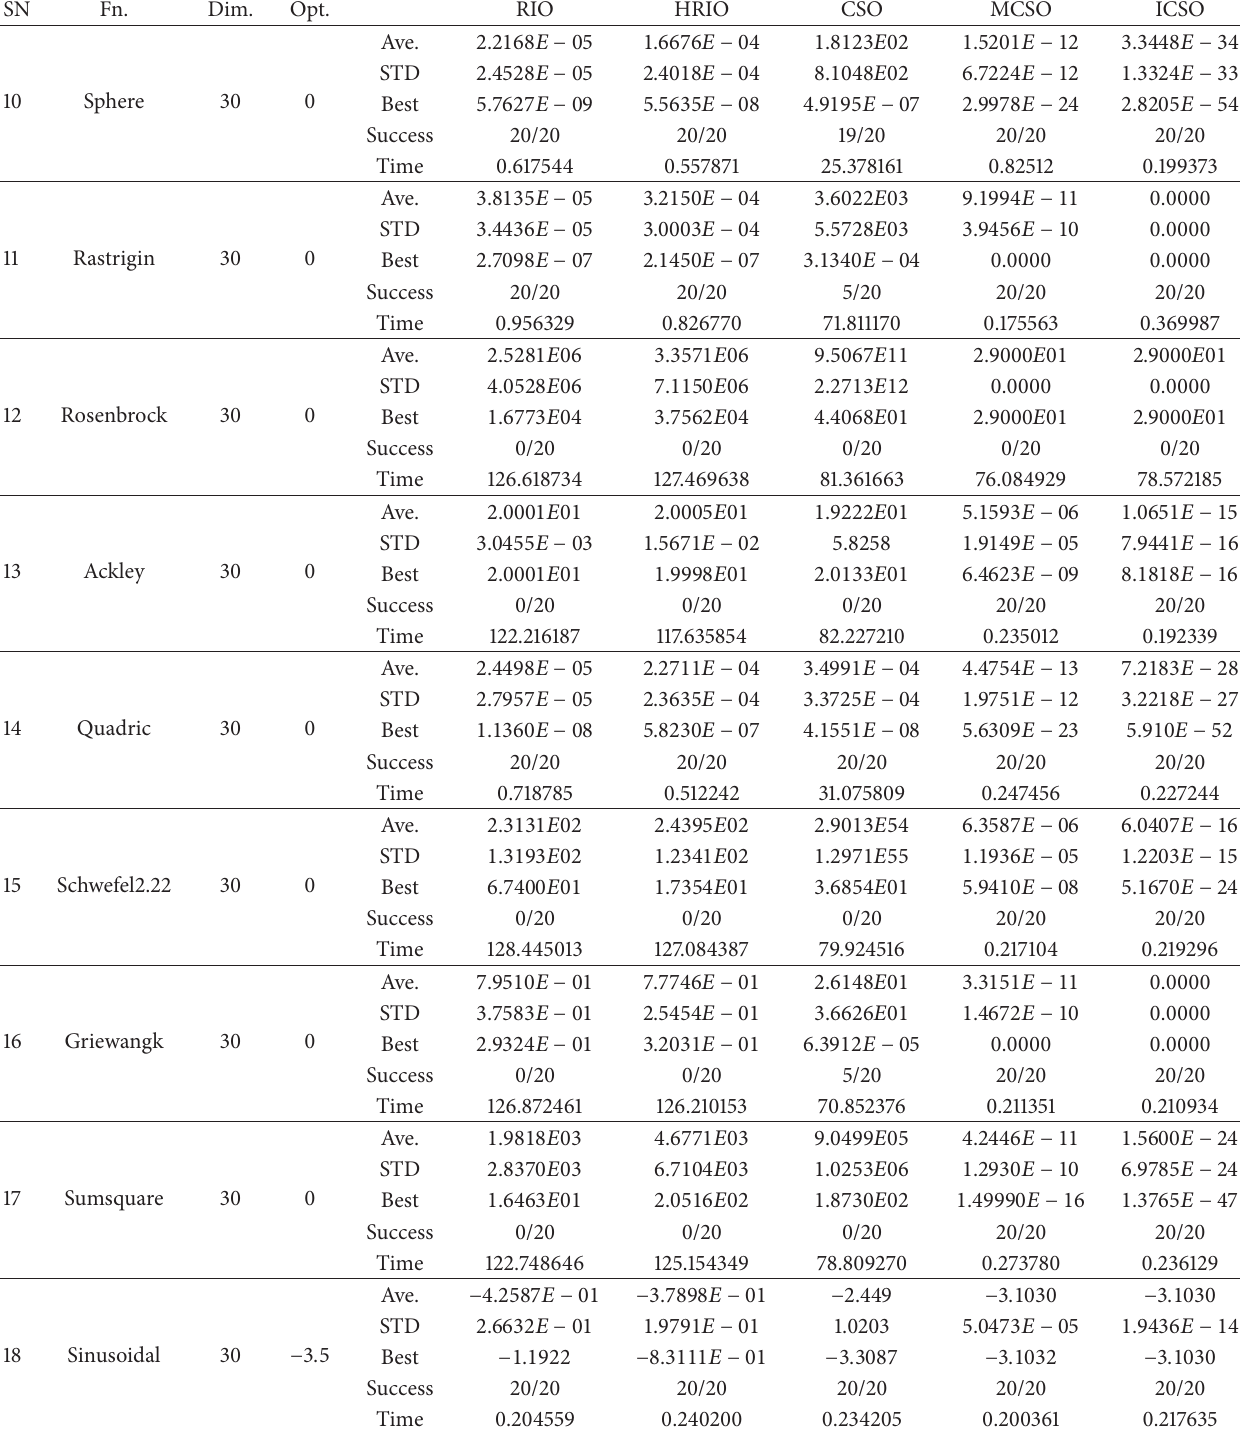
Table 3: Simulation results of RIO, HRIO, CSO, MCSO, and ICSO. SN